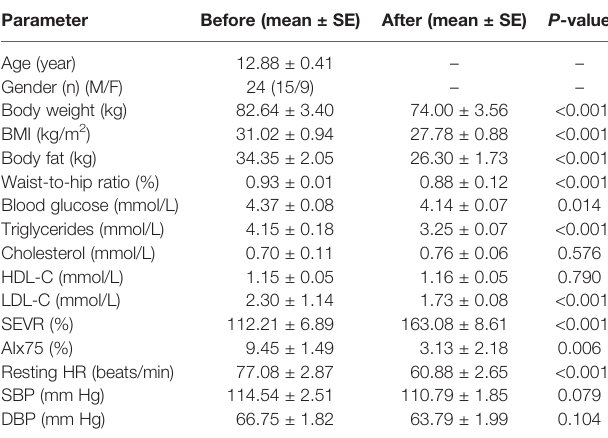
TABLE 1 | Anthropometric, metabolic, and hemodynamic parameters of participants before and after 6-week combined exercise and diet intervention. Parameter Before (mean ± SE) After (mean ± SE) P